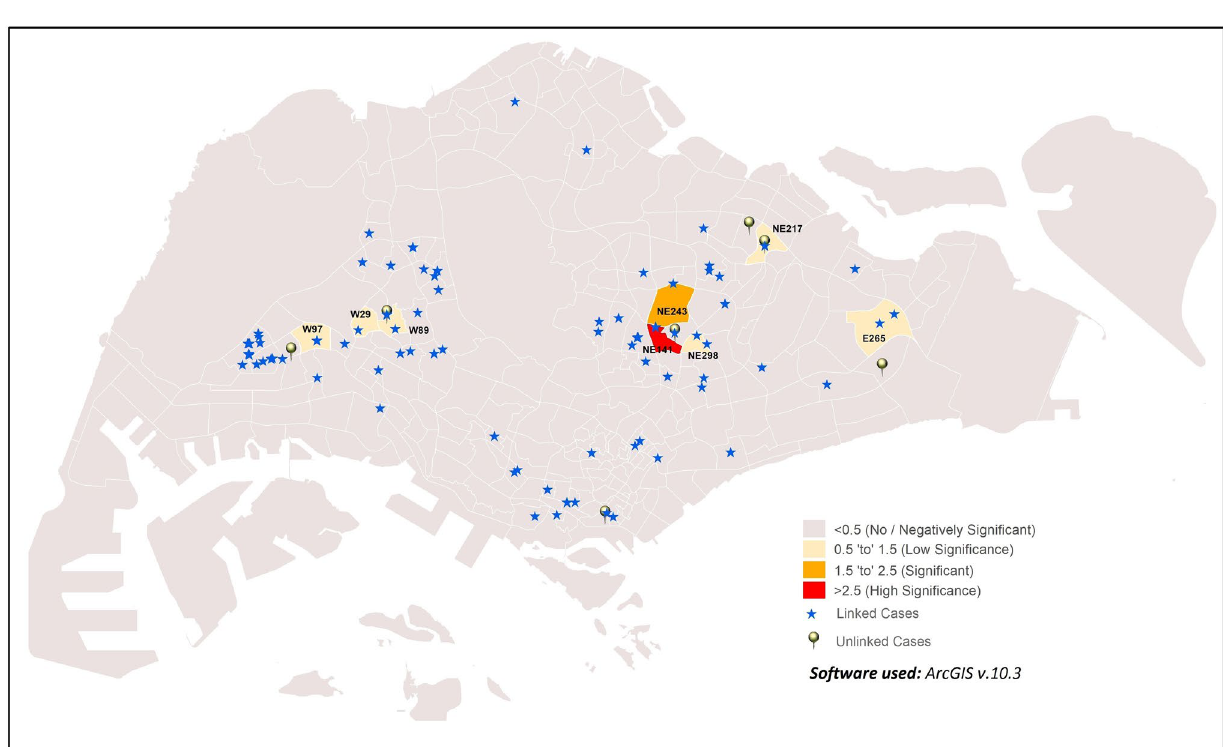
Figure 7. Distribution of sub-zones with correlation of unlinked cases on linked